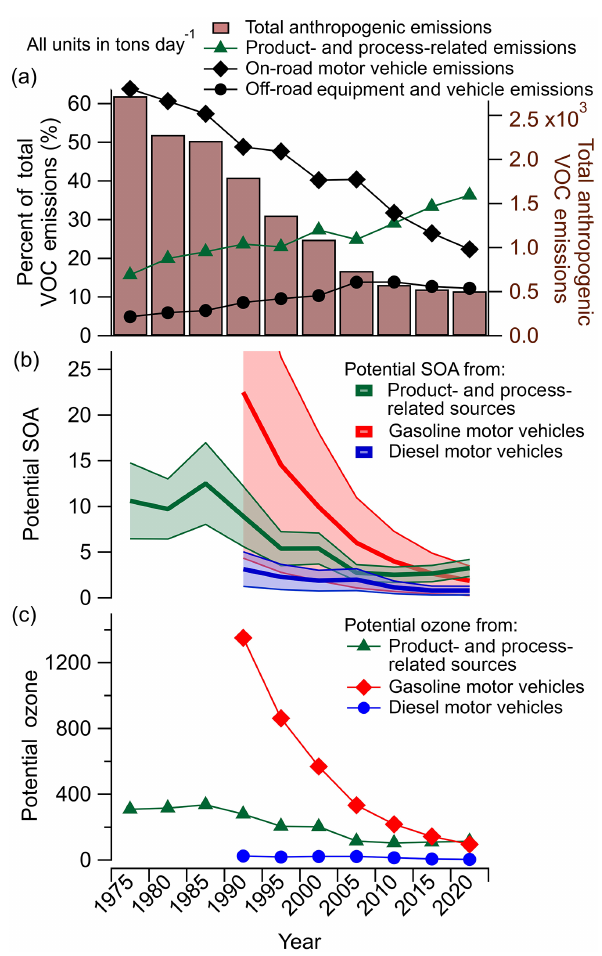
Figure 2. Emissions and potential air quality impacts of product- and process-related sources and motor vehicles over time in the South Coast Air Basin (i.e., Los Angeles). (a) Total anthro- pogenic VOC emissions (excluding ethane). (b) Potential SOA from product- and process-related emissions compared to on-road motor vehicles, with uncertainties based on the ranges of compound-class- specific SOA yields. (c) Ozone formation potential via compound- specific maximum ozone incremental reactivity values (SAPRC, no uncertainty given). All units are in tday − 1 for panels (a–c) . Product- and process-related results are produced using CARB emissions data and EPA source profiles; see Methods for further detail. Note: none of the panels include VOCs, IVOCs, or SVOCs from products and processes that we identify in Sects. 2 and 4 as missing from emissions inventories, but SOA and ozone for- mation from motor vehicle emissions does include IVOCs and SVOCs. Maximum potential SOA from gasoline vehicles in 1990 was ∼ 41tday − 1 (off graph). Pre-1990 potential SOA and ozone for motor vehicles is excluded due to the lack of fleet-resolved